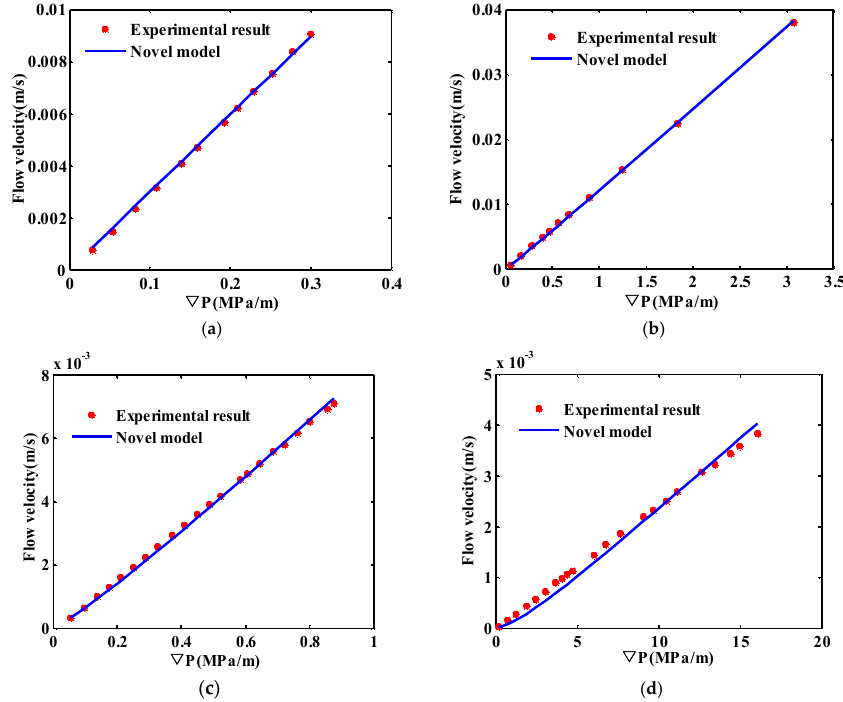
Figure 8. Comparison of calculated velocity versus ∇ P and Wu’s experimental results [22,40]: ( a ) R = 15.36 μ m; ( b ) R = 10.03 μ m; ( c ) R = 7.61 μ m; ( d ) R = 1.38 μ m.